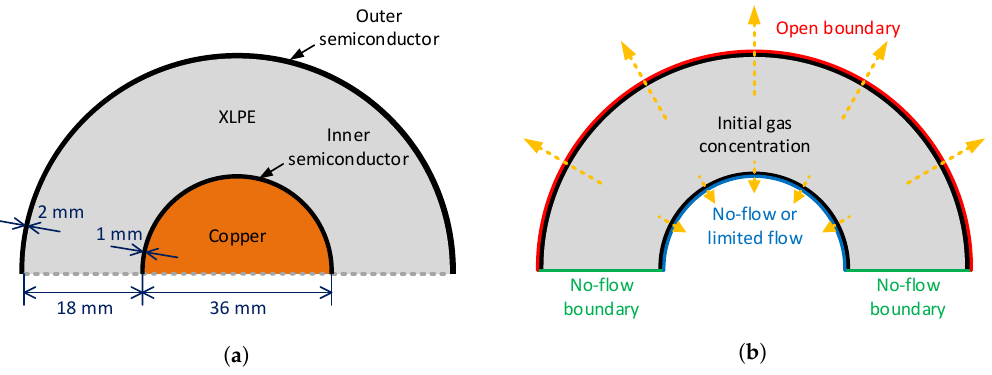
Figure 1. A two-dimensional schematic representation of a 132-kV HV cable with an 18-mm XLPE insulation: ( a ) geometry and ( b ) initial and boundary conditions for the methane